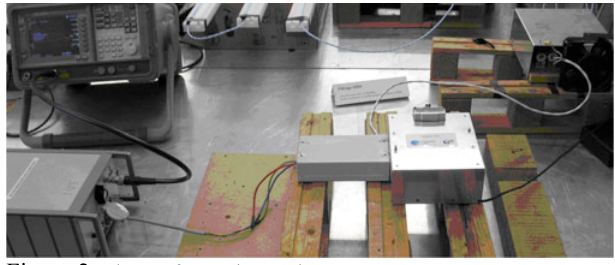
Figure 2: Photo of experimental setup